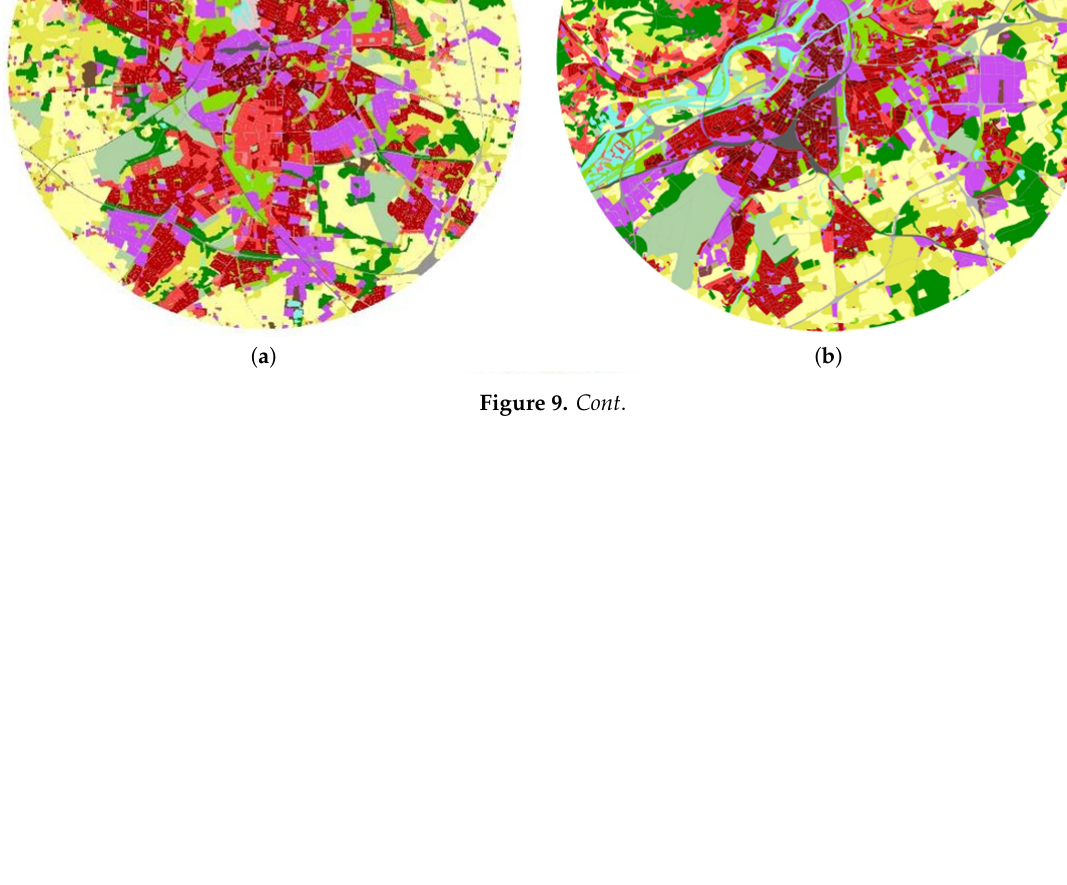
( c ) Figure 9. An interesting triplet of look-alike cities. ( a ) Odense; ( b ) Metz; ( c ) Münster. (Source: [29], Metz 16 December 2015, Münster 23 March 2018; circular extracts – author’s work). A high occurrence of discontinuous medium density urban fabric can be seen in opposition to a continuous urban fabric. This is typical of Western European cities, but not Eastern European cities (e.g., cities of Zalaegerszeg and Žilina). Forests exist in small isolated pockets. The land use pattern is